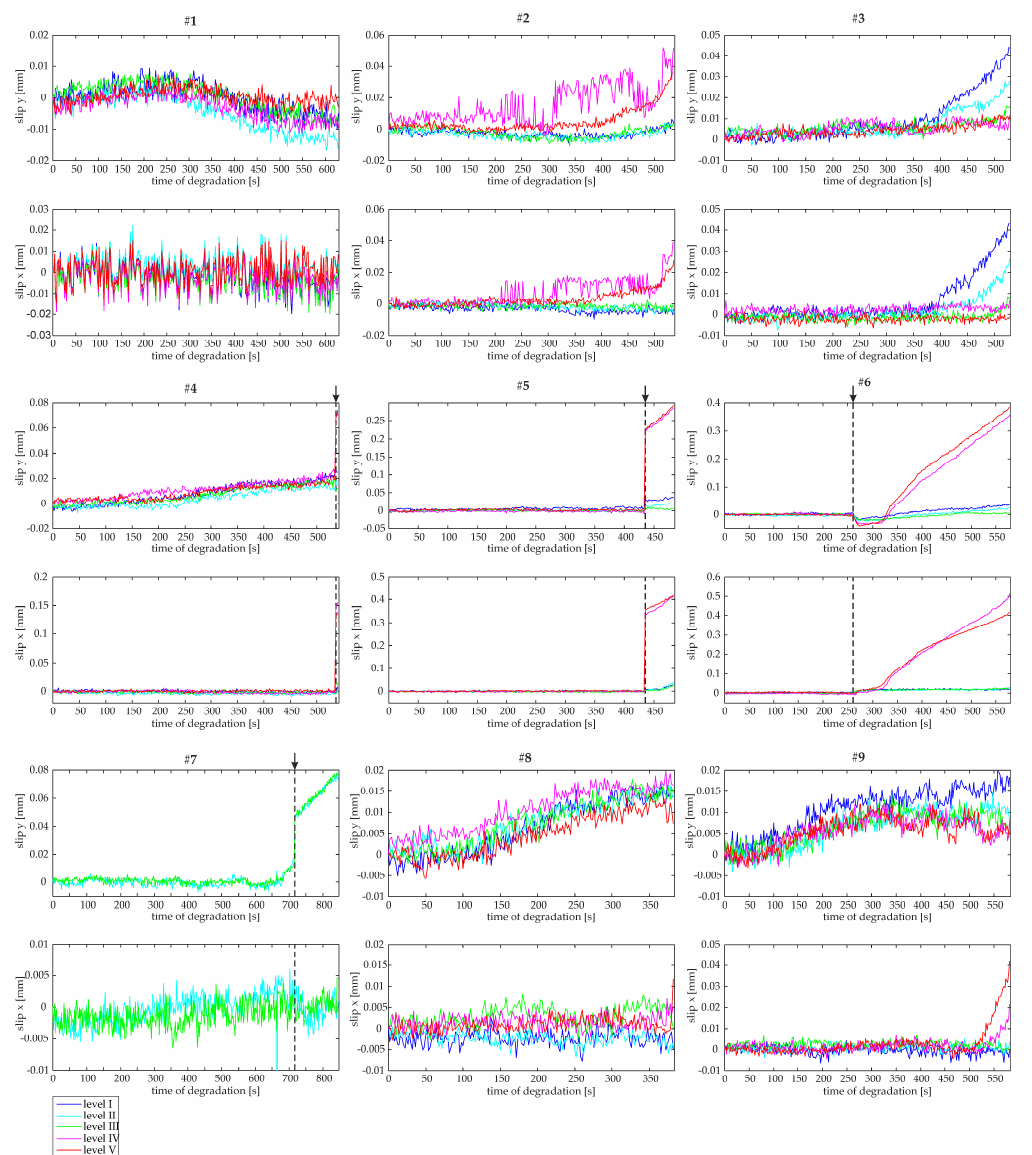
Figure 9. Interface slip between steel and concrete for tested push-out specimens ( #1 – #9 ).